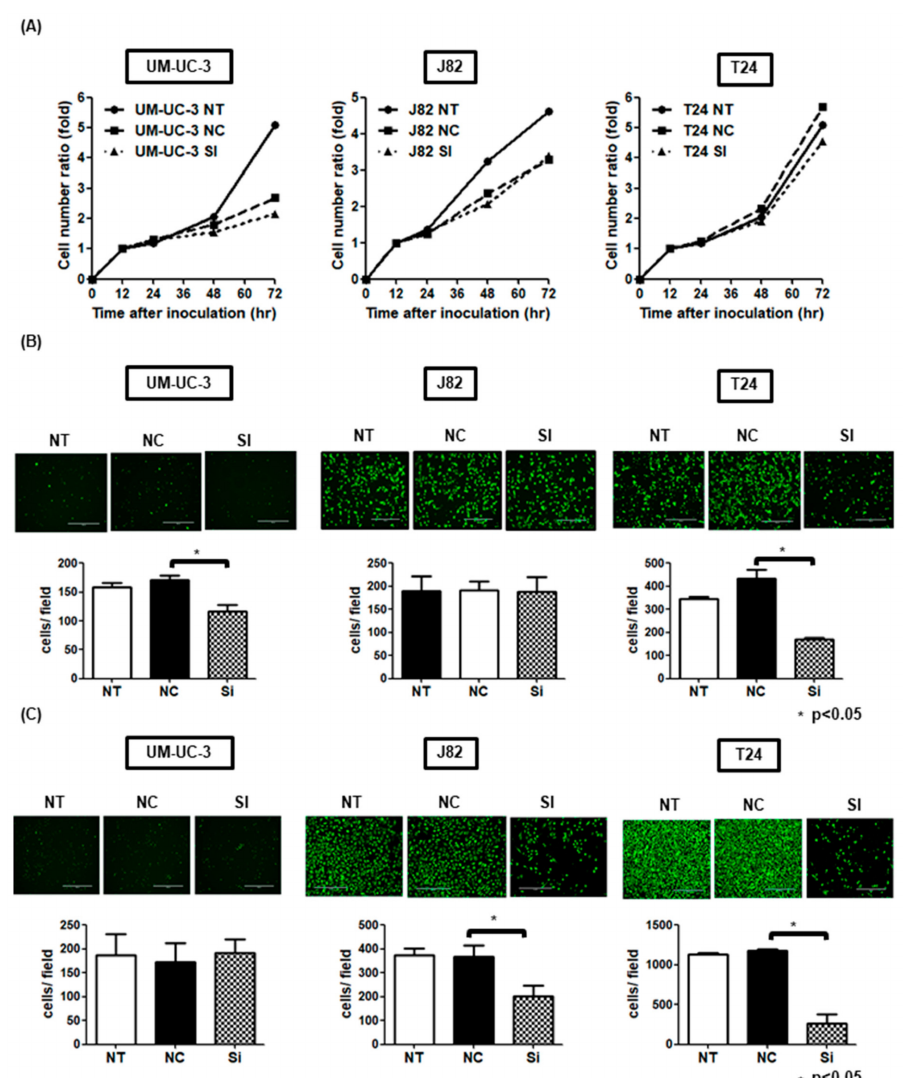
Figure 4. ( A ) In cell proliferation assays, the proliferation ability of UM-UC-3 NT tended to be higher than that of NC and SI compared to T24. But there were no significant di ff erences in the proliferative ability for all three cell lines. ( B ) In migration assays, there was significant decreased migration ability of si-RNA transfected cells than negative control cells in UM-UC-3 and T24. ( C ) In the Matrigel invasion assay, there was significant decreased invasion ability of si-RNA transfected cells than negative controls in J82 and T24. NT: No treatment; NC: Negative control; SI: DAB2 -si